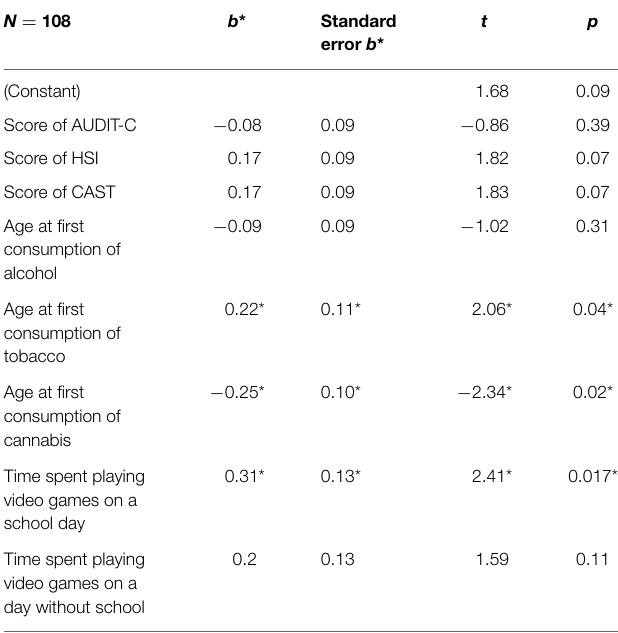
TABLE 4 | Multiple regressions with PUVG score as dependent